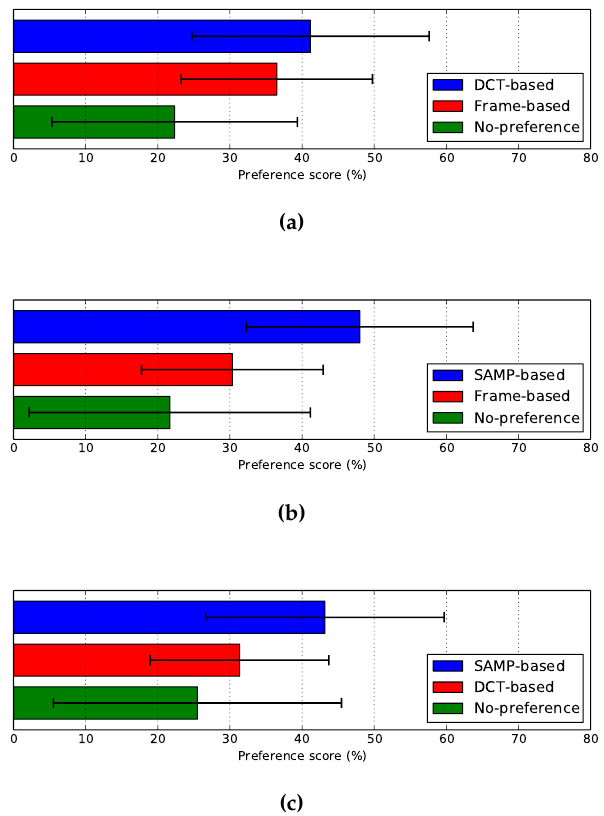
Figure 6. Preference scores with 99% confidence for each system pair: ( a ) Frame-based model versus DCT-based model, ( b ) SAMP-based model versus frame-based model, and ( c ) SAMP-based model versus DCT-based